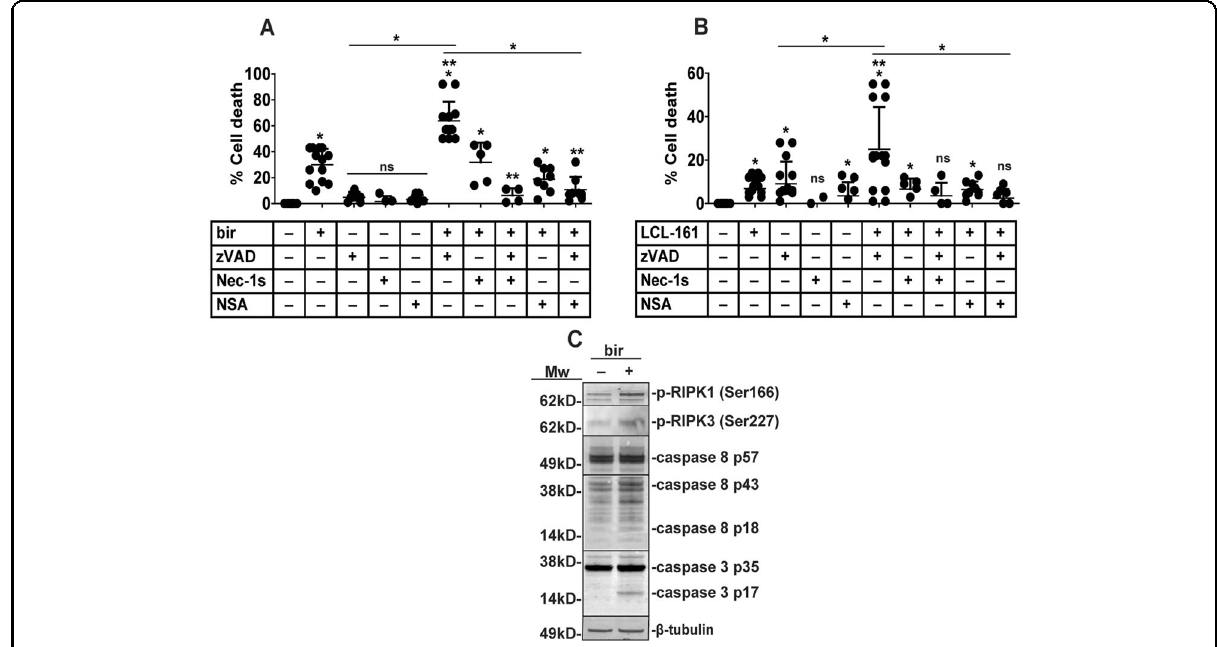
Fig. 3 Birinapant induces necroptosis and apoptosis in human pre-osteoclasts. Pre-OC were treated with birinapant ( A ) or LCL-161 ( B ) in combination with 20 μ M zVAD, 1 μ M NSA or 10 μ M Nec-1s for 18 h before measuring the cytotoxicity by LDH-release, shown for 13 (A) and 15 (B) donors. Single asterisk denotes statistical signi fi cance as compared to the untreated control or between indicated groups, double asterisk denotes statistical signi fi cance as compared to SM treatment alone ( p < 0.05, One-way ANOVA). Individual donors, average, and SD are shown. Pre-OC were treated with 1 µM birinapant for 4 h and cell lysates analyzed for caspase 8 cleavage, caspase 3 cleavage, RIPK1 serine 166 phosphorylation and RIPK3 serine 227 phosphorylation by immunoblotting ( C ). β -Tubulin is loading control. One representative of 7 donors is